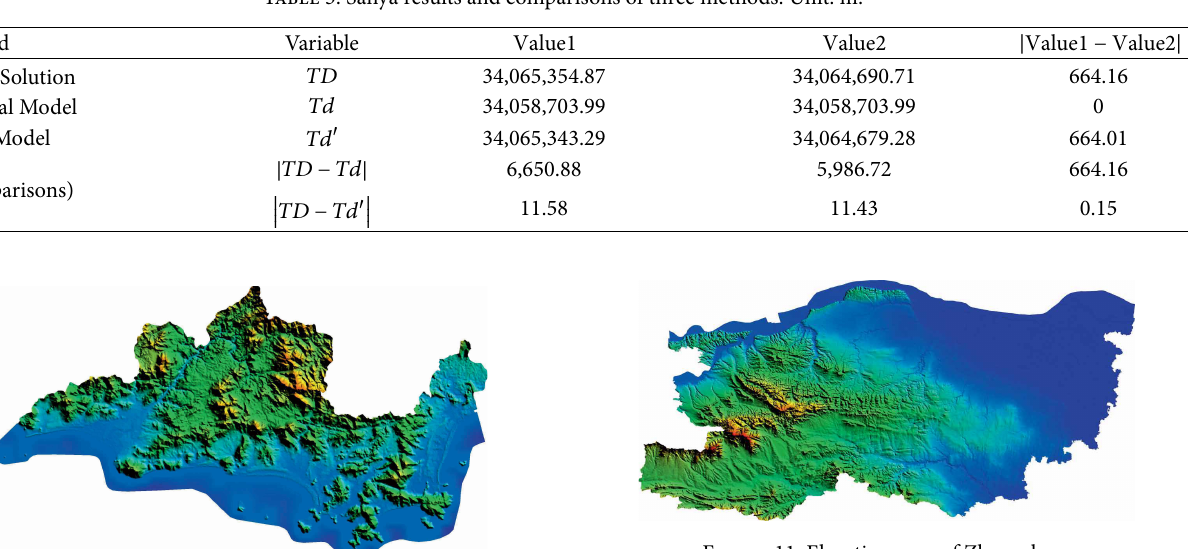
Figure 11: Elevation map